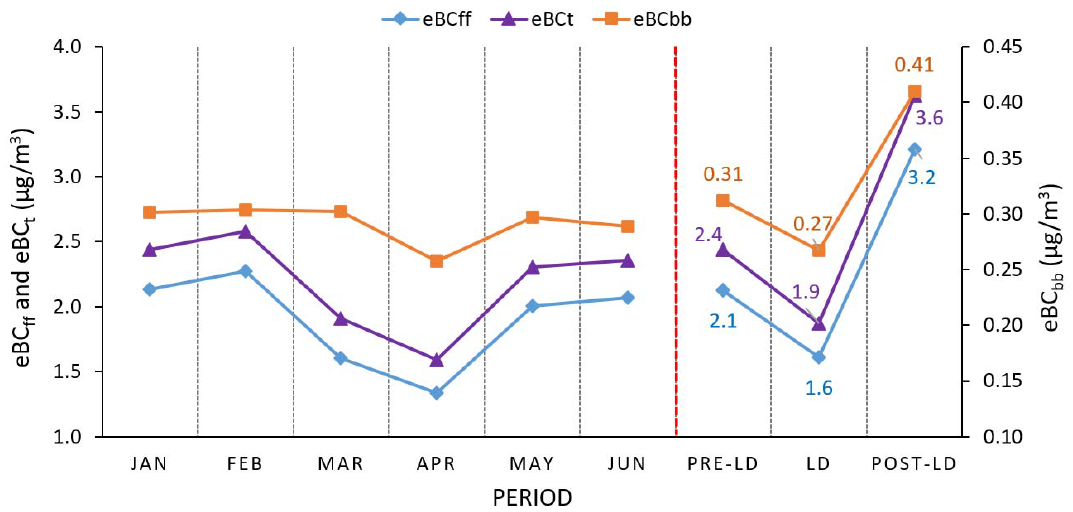
Figure 4. Monthly changes in equivalent black carbon (eBC) concentrations and their variations through the Pre-LD, LD, and Post-LD stages.